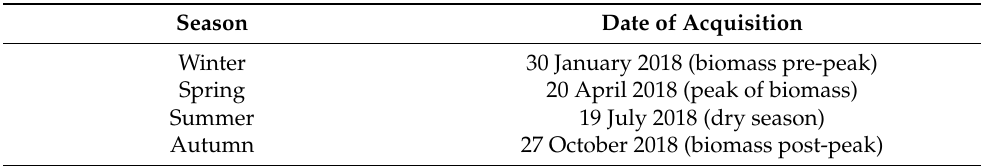
Table 2. List of the multi-season Sentinel-2 images